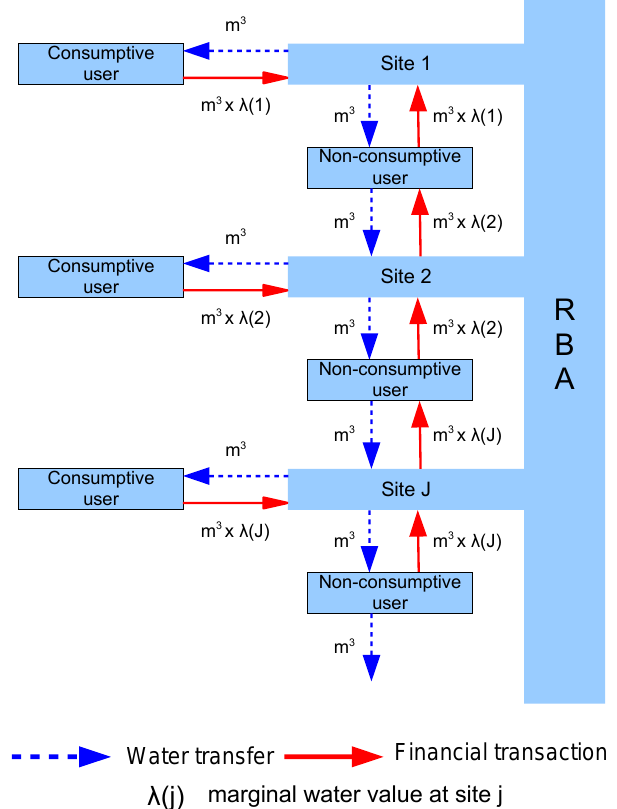
Figure 3. Collection of bulk water charges for a given time period.